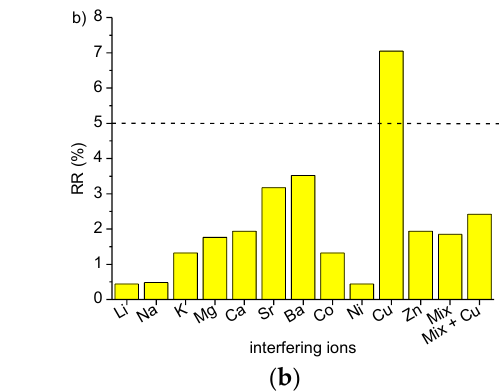
Table 2. Determination of lead(II) in spiked tap water samples using crown 3 as colorimetric probe. Water sample